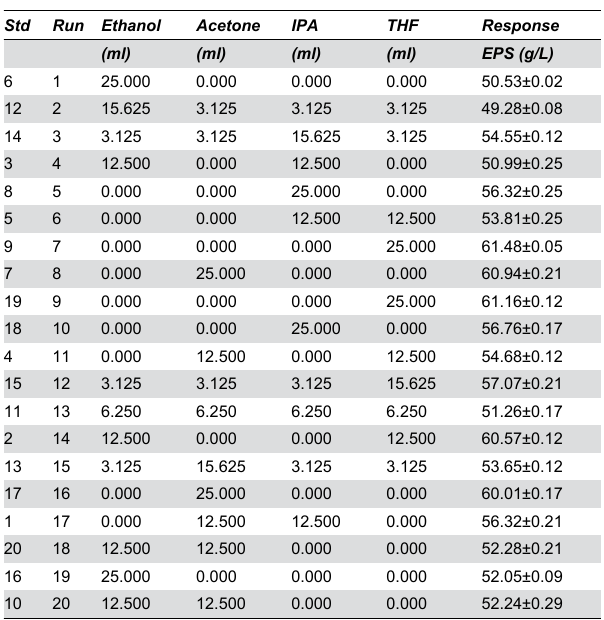
Table 2. Experimental data obtained from D-Optimal RSM studies to understand the effect of interaction among organic solvents on precipitation of